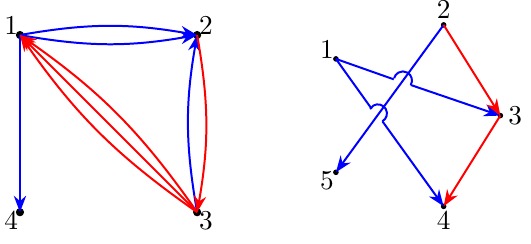
Figure 1 . The graph associate to the kinematic structures h 23 ih 31 i 3 [12] 2 [14][32] and h 23 ih 34 i [13][14][25]